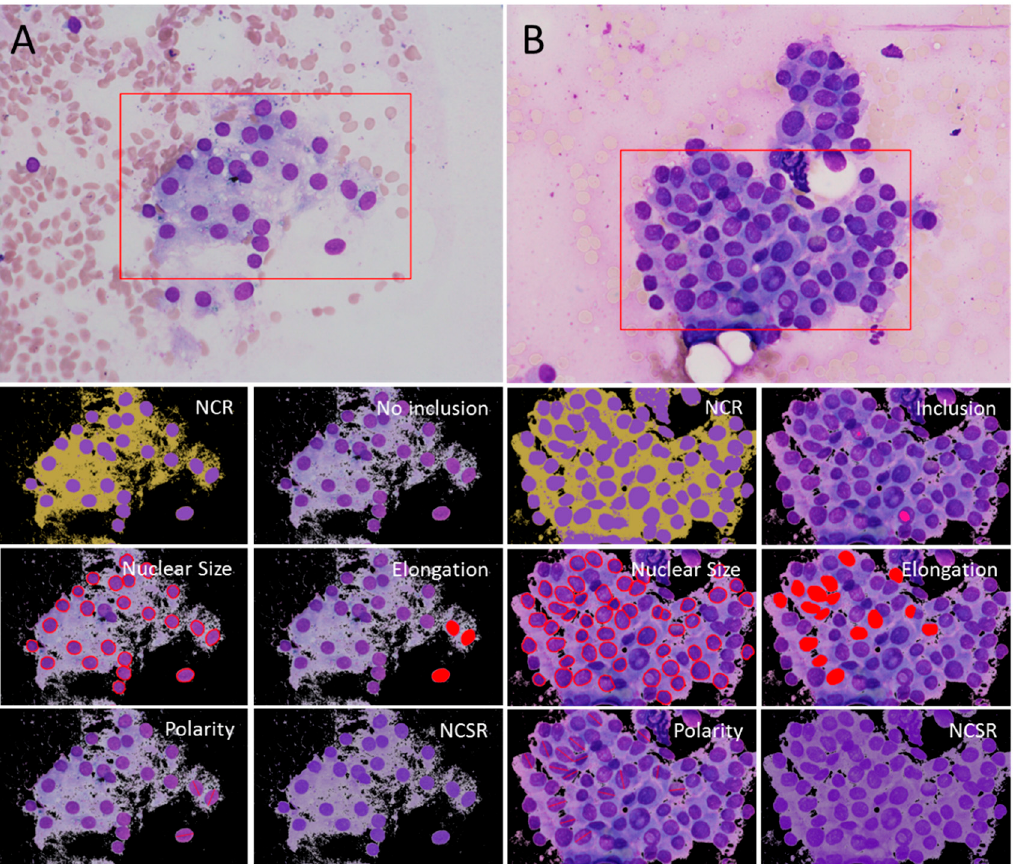
Figure 4. Visual comparison for clinically important features. The images from a case of hyperplasia ( A ) and a case of papillary thyroid carcinoma ( B ) acquired from a thyroid fine-needle aspiration cytology smear (Riu’s stain, 400×). The image (red rectangle region of interest) was cropped for computerized analysis. NCR (nuclear-cytoplasmic ratio visualized with nuclei in purple, cytoplasm in yellow), intranuclear inclusion (pink), nuclear size (nuclei segmented by red contours), elongation (elongated nuclei in red), polarity (alignment of red major axes of elongated nuclei), and NCSR (nuclear-cytoplasmic saturation ratio visualized with a saturation contrast between nuclei and cytoplasm).